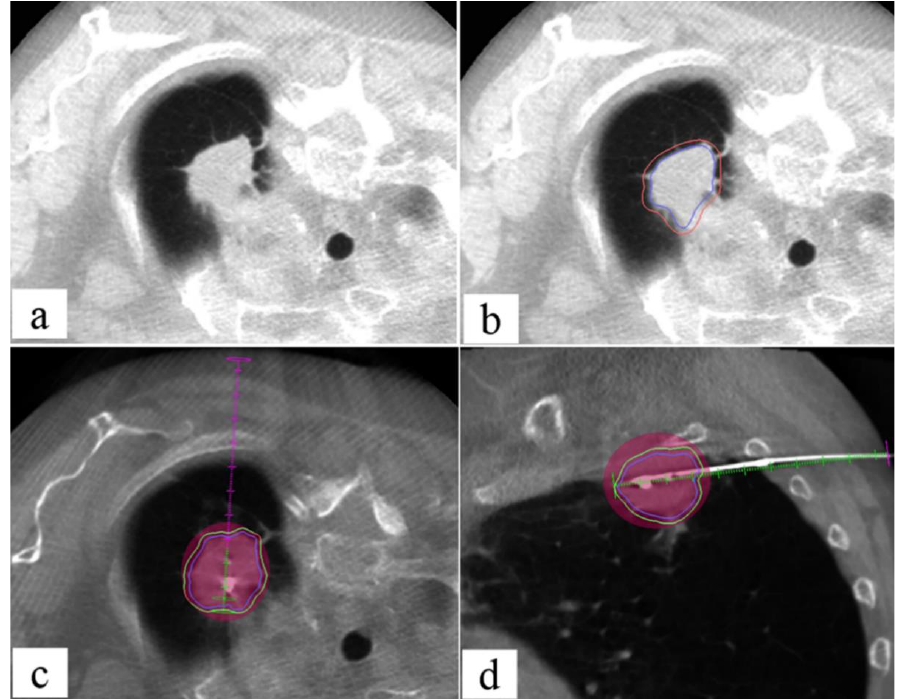
Figure 5. Seventy-five-year-old female, pulmonary adenocarcinoma: MWA ablation. ( a ) Pre-procedural CBCT: lesion visualization; ( b ) with lesion segmentation (blue line) and adding 5 mm safe margins (orange line); ( c ) ablation planning: MW virtual probe with predicted ablation area (manufacturer specific) (pink area) overlaying to segmented lesion (blue line) with 5 mm safe margins (green line) covered in axial plane; ( d ) intra-procedural CBCT: MW probe placement with all lesions with 5 mm safe margins (green line) covered by the predictable ablation area in sagittal plane.